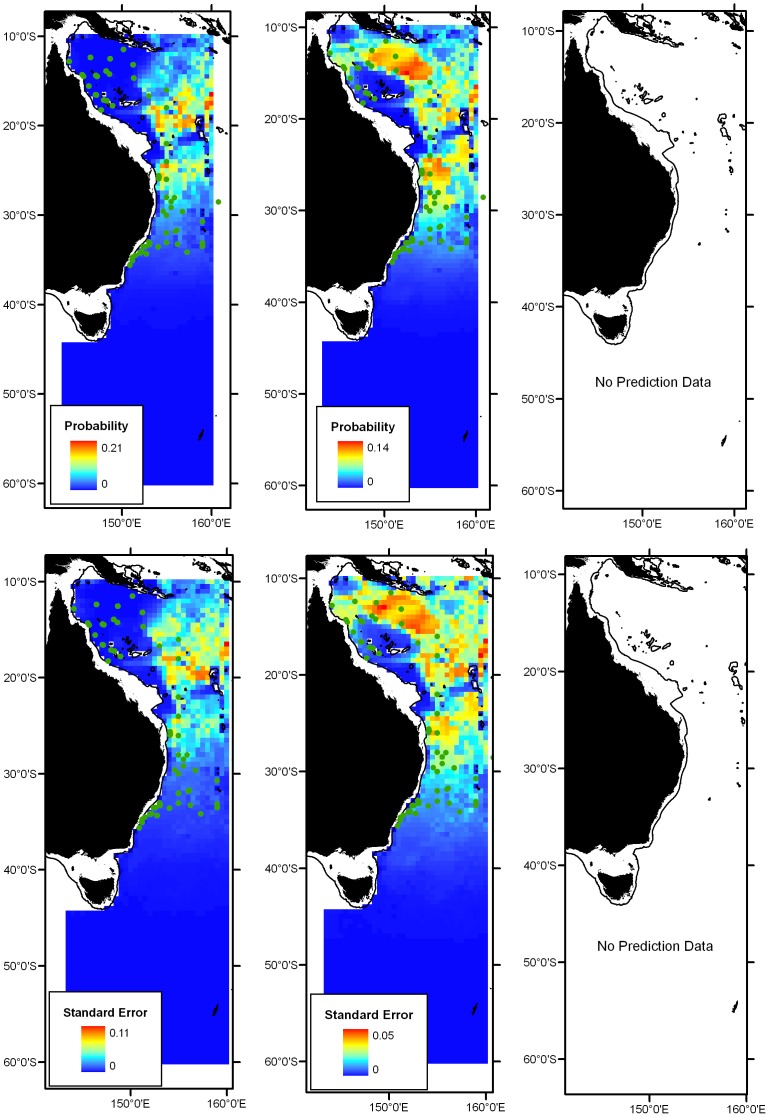
Predicted distributions of Diaphus mollis (top row) and standard errors (bottom row).From left to right: 0 m, 150 m and 500 m depth envelopes. Green dots indicate all occurrence records of D. mollis.